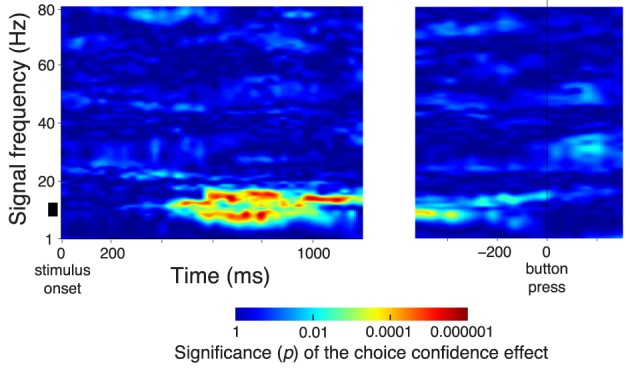
The spectrum of the confidence-related neural effect at a single parietal channel CP3. Same format as in Figure 3A, for data at a single parietal channel CP3.